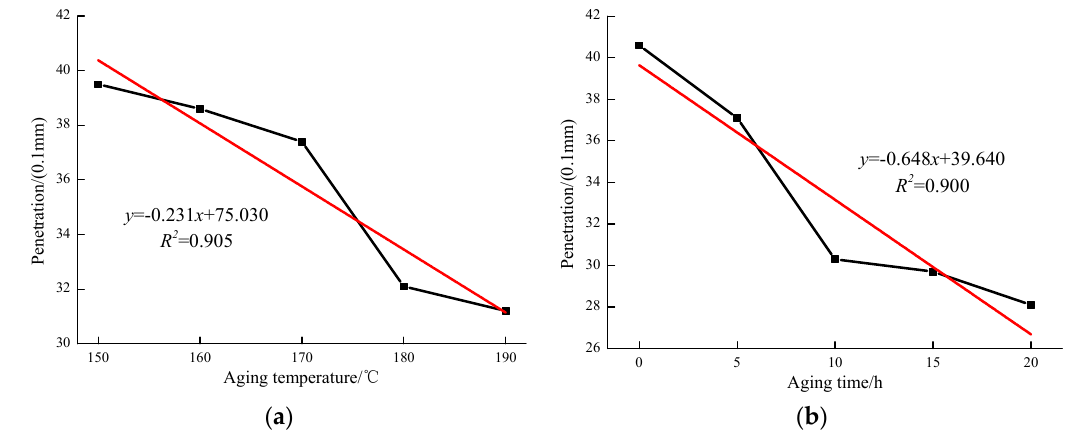
Figure 2. Penetration values of MACRMA at different aging conditions: ( a ) aging temperature and ( b ) aging time.